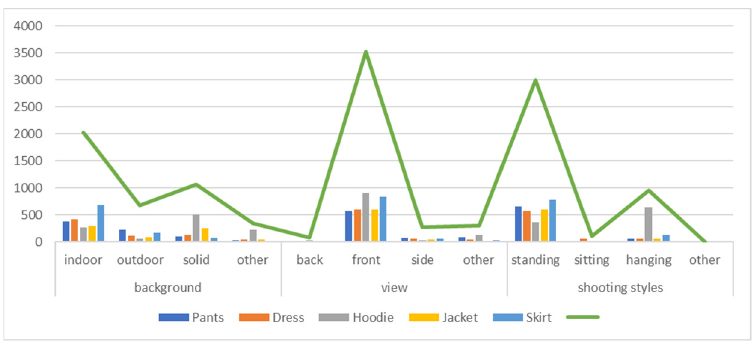
Figure 4. Visualization of the Distribution for Dataset.